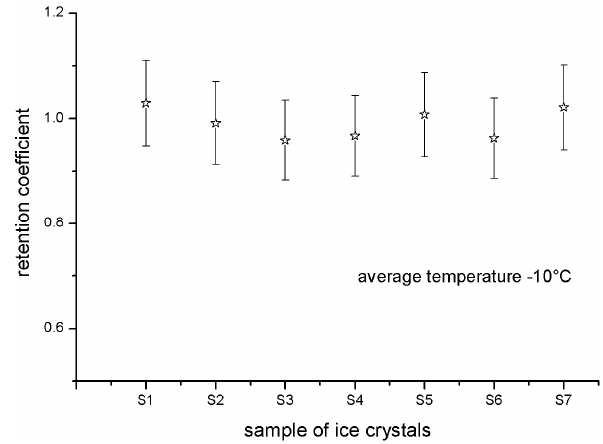
Fig. 2. Retention coefficient of HNO 3 , determined with freely Figure 2. Retention coefficient of HNO 3 , determined with freely floated ice crystals rimed 2 floated ice crystals rimed with solution droplets with a concentra- with solution droplets with a concentration of 120 ppmv. Several samples at an average air 3 tion of 120ppmv. Several samples at an average air temperature of − 10 ± 2 ◦ temperature of -10 ± 2°C. 4